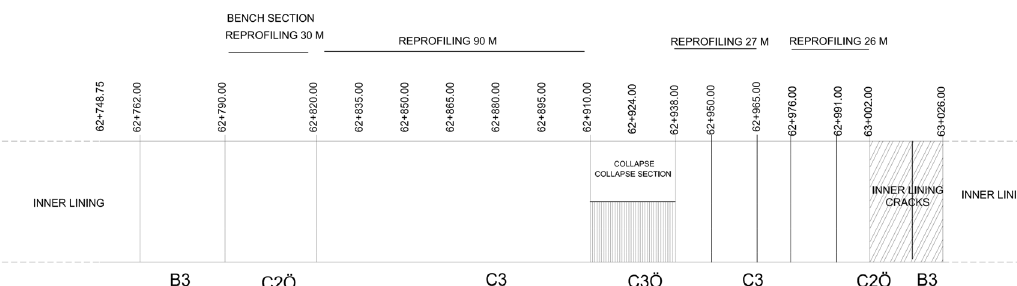
Figure 7. Tunnel excavation situation.